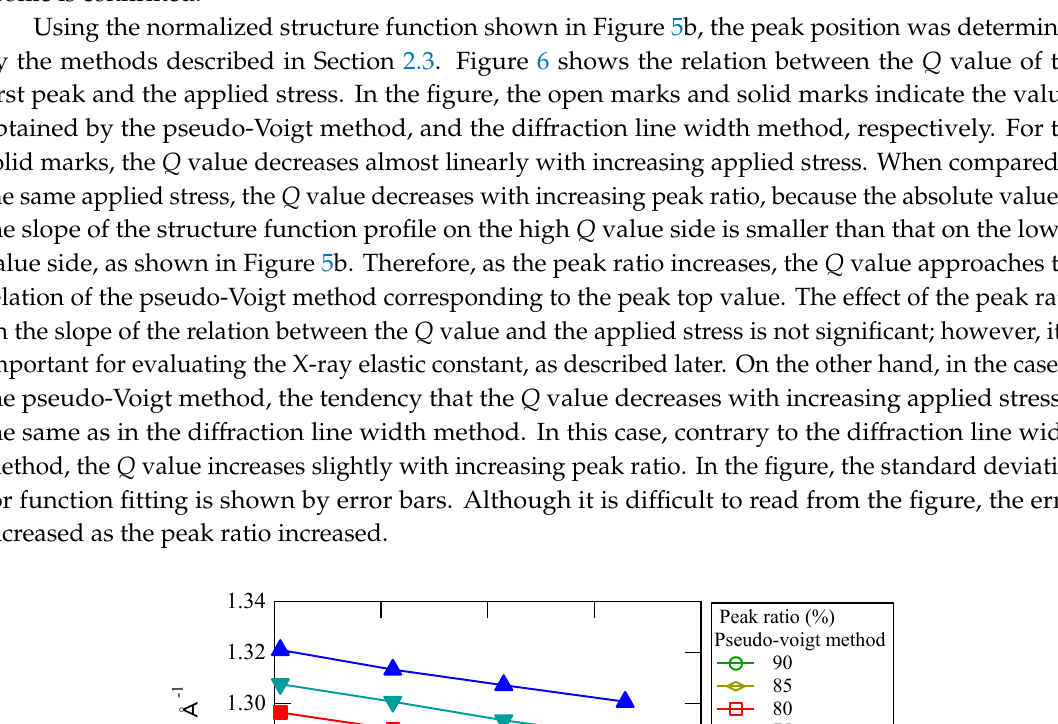
Figure 7. Relation between applied stress and strain measured by X-ray for line width method. The X-ray elastic constant can be calculated from the slope of the fitted linear curve in Figure 7. The obtained Young’s modulus measured by X-ray is summarized in Figure 8. The circles in the